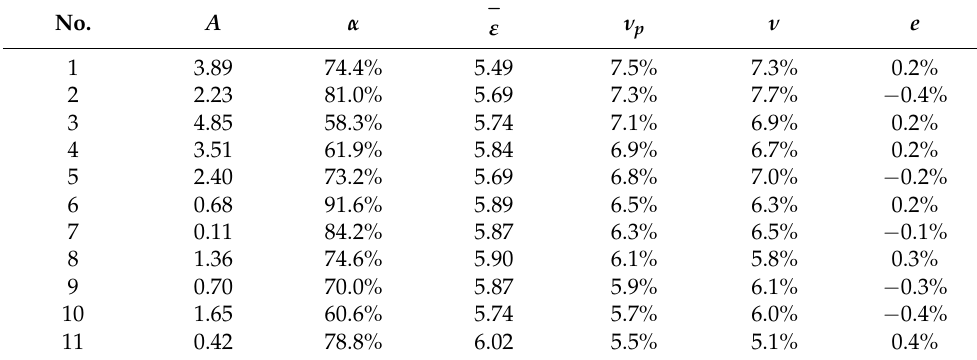
Figure 15. Distribution map of connected risk areas in unit 2. Table 3. The regional indicators of the verification area and the test results of core samples.